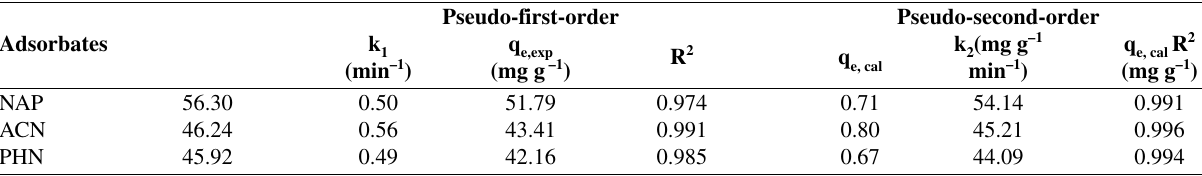
Table 3. Kinetic parameters of NAP, ACN, and PHN adsorption on GO-9-AA